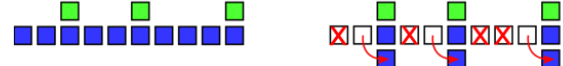
Figure 1. Systematic layer composition approach for dealing with incomplete data. In our use case, the green and the blue squares symbolize satellite observations and weather variables, respectively.